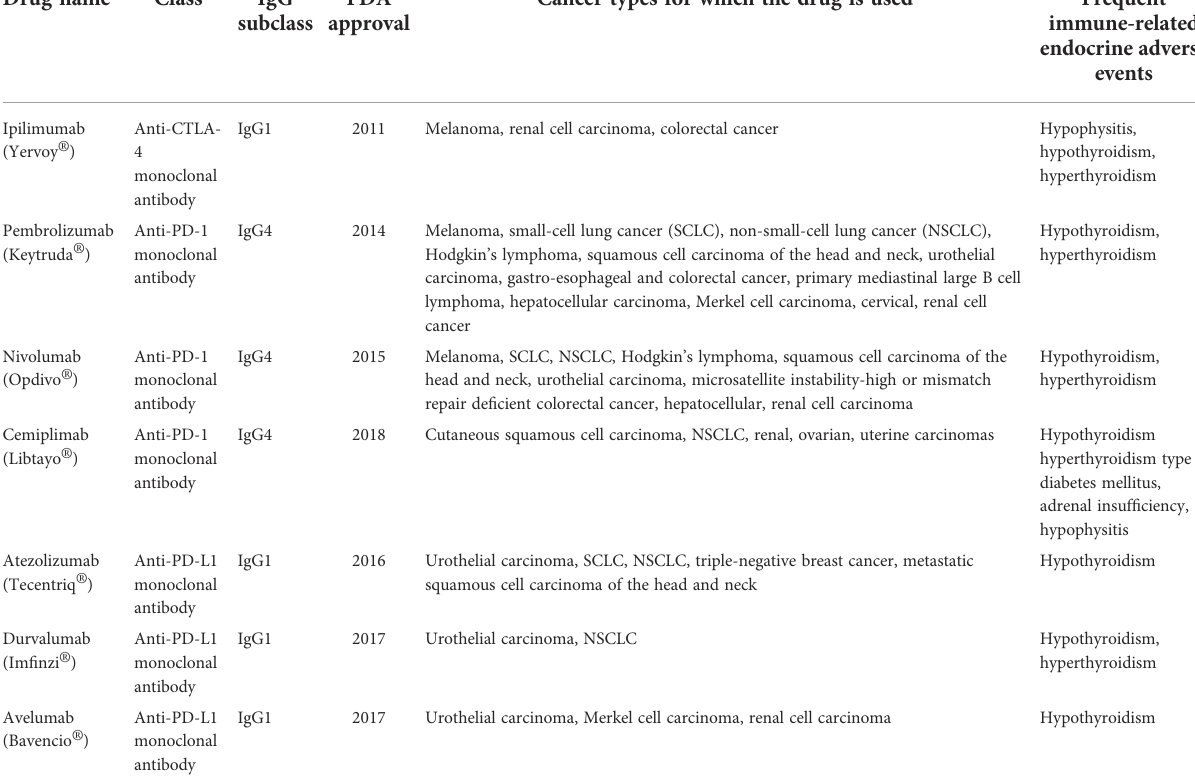
TABLE 1 Immune checkpoint inhibitors, cancer types for which they are used and the most frequently induced immune-related endocrine adverse events. Drug